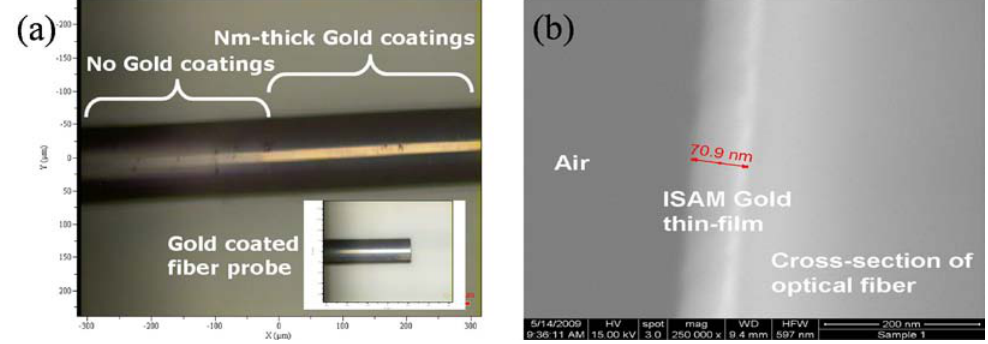
Figure 2. (a) Color picture of ISAM gold film coated fiber probe imaged by brightfield microscopy, inset is a cleaved fiber probe with gold coatings; (b) SEM picture of cross-section of a cleaved optical fiber coated by 10-bilayer ISAM gold